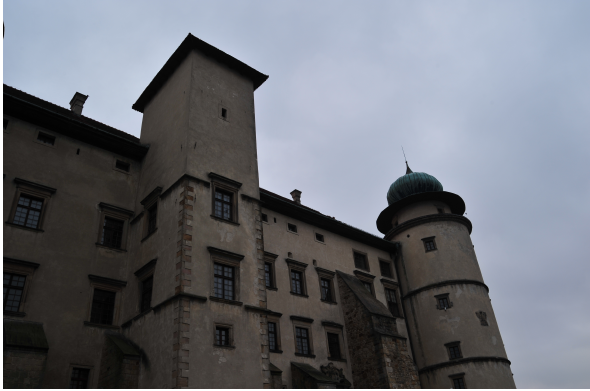
Figure 1. Example of an underexposed image.